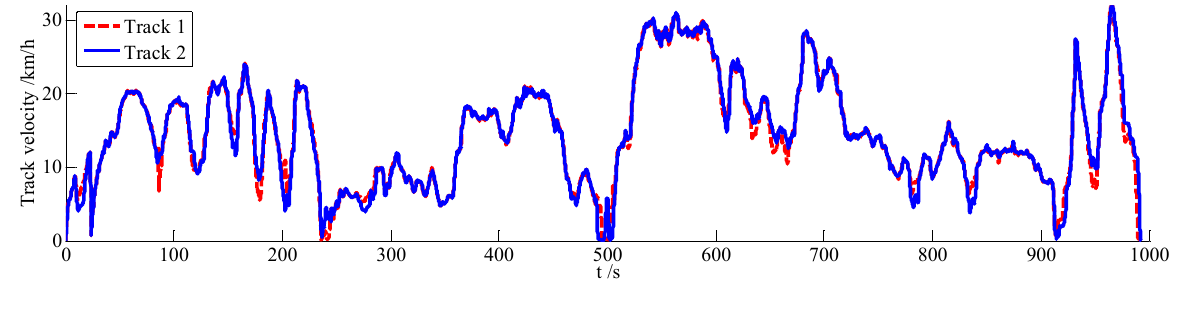
Figure 2. The speed profile used as the driving cycle for the tracked vehicle studied.